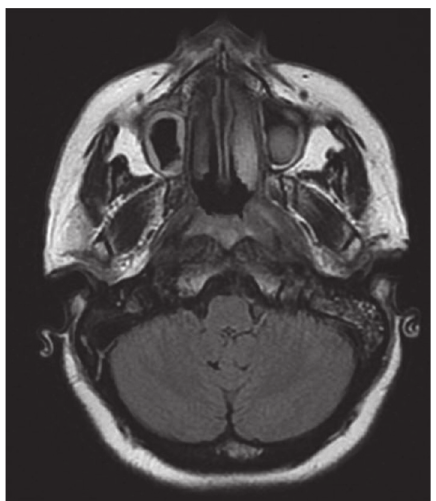
Figure 4: MRI brain axial view showing bilateral maxillary sinusitis and left